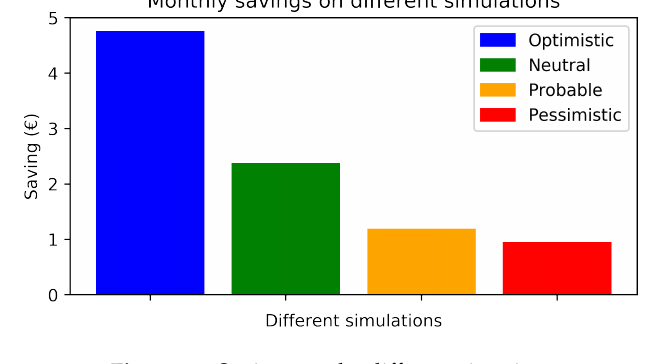
Figure 11. Savings on the different situation. Table 4. Different simulations and their saves.